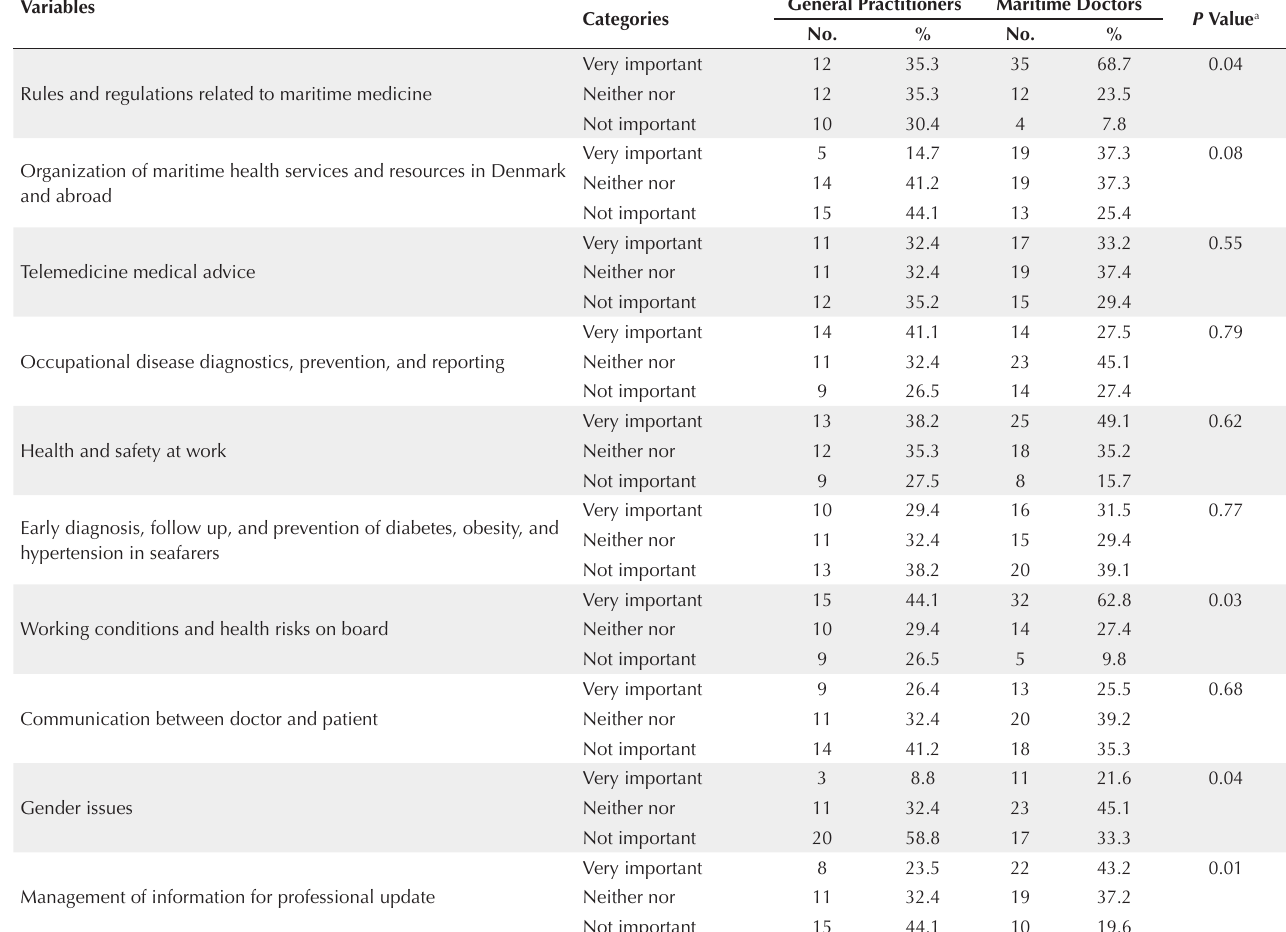
Table 3. Common Topics and Perceived Training Needs of General Practitioners’ (n=34) and Maritime Doctors